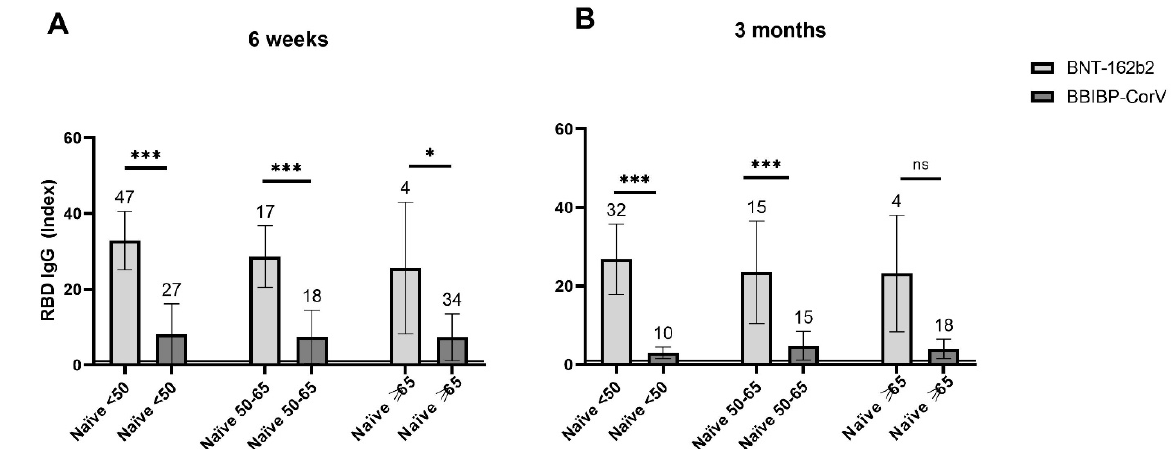
Figure 4. Mean levels of SARS-CoV-2 spike protein RBD-specific IgG antibodies post vaccination in naïve recipients of BNT-162b2 and BBIBP-CorV according to age (<50, 50–65, ≥ 65). ( A )—at 6 weeks post vaccination, ( B )—at 3 months post vaccination. ( A , B )—Sample sizes are shown above standard deviation (SD) error bars. Horizontal line at an index of 1 indicates test cut-off. * p ≤ 0.05; *** p ≤ 0.001; ns—non-significant.